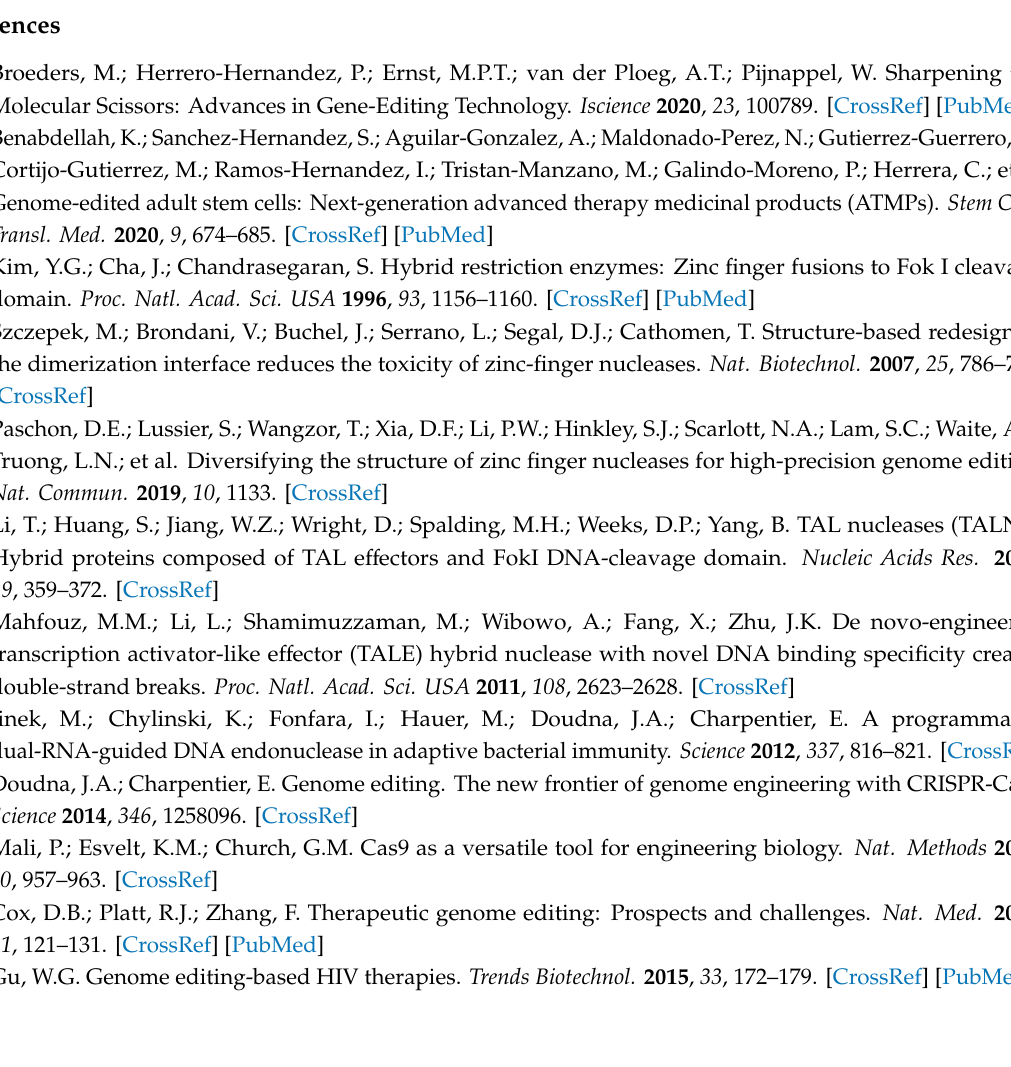
Figure S1: Scheme showing the di ff erent possibilities of DNA donor insertions at the K562 SEWAS84 cellular reporter model (eGFP-OFF / dsRED-ON model), Figure S2: Analysis of on-target and o ff -target donor integration by PCR analysis of clones., Figure S3: Scheme showing the di ff erent possibilities of DNA donor insertions at the 13-K562GWP cellular reporter model (eGFP-ON / dsRED-OFF